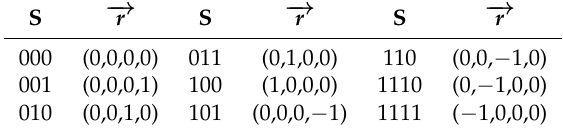
Table 1. An example of a one-to-one correspondence table from the data chunk of S to V u